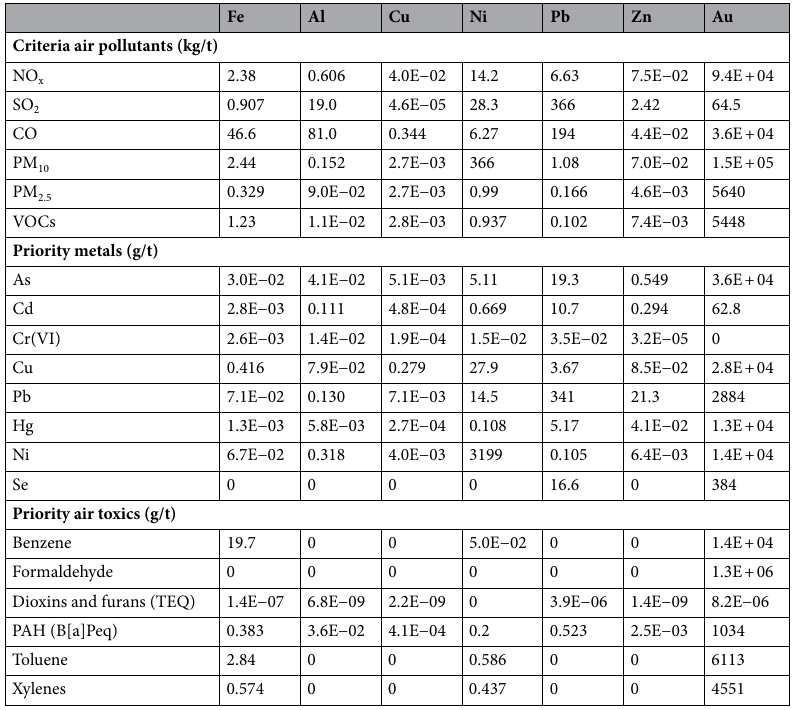
Table 2. Atmospheric emissions of criteria and priority atmospheric pollutants expressed on per tonne of metal